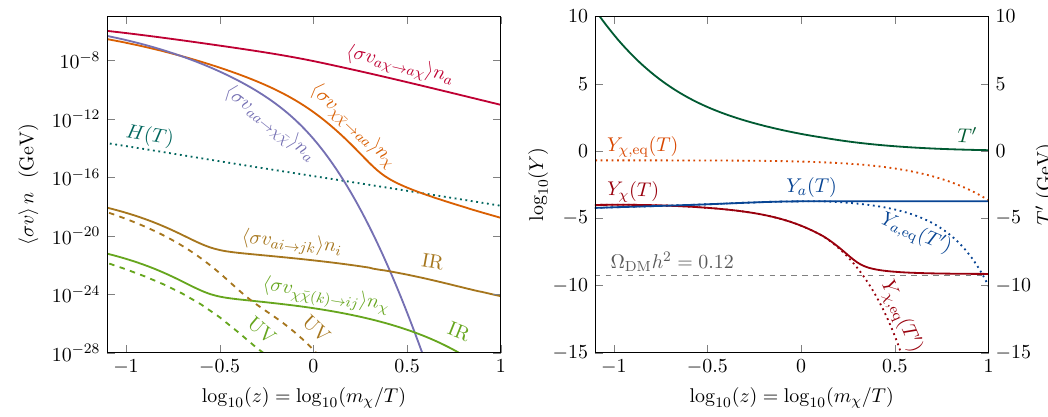
Figure 7 . Illustrative example of the evolution of the number densities and the reaction rates in the DFO scenario for m = 10 GeV and m = 1 GeV and for a set of couplings which give the χ a measured dark matter relic abundance: g = 9 . 44 · 10 − 12 GeV − 1 and g = 1 . 06 · 10 − 2 GeV − 1 . aff aχχ Left: Evolution of the different terms competing on the right hand side of the Boltzmann equations for n and n as a function of log ( z ) = log ( m ) . We also plot the evolution of the reaction χ a χ /T 10 10 rate for elastic scattering among the hidden sector particles, aχ → aχ . Right: The evolution of the comoving number density of χ (red) and a (blue) as a function of log ( z ) = log ( m ) . The χ /T 10 10 equilibrium distributions Y ( T 0 ) (dotted red) and Y ( T 0 ) (dotted blue) and Y ( T ) (dotted χ, eq a, eq χ, eq orange) are also shown for reference. We plot along the evolution of the hidden sector temperature T 0